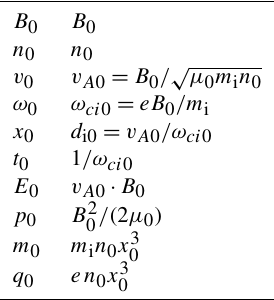
Table 1. Background values used to normalise all variables in the solver (cf. Eq.